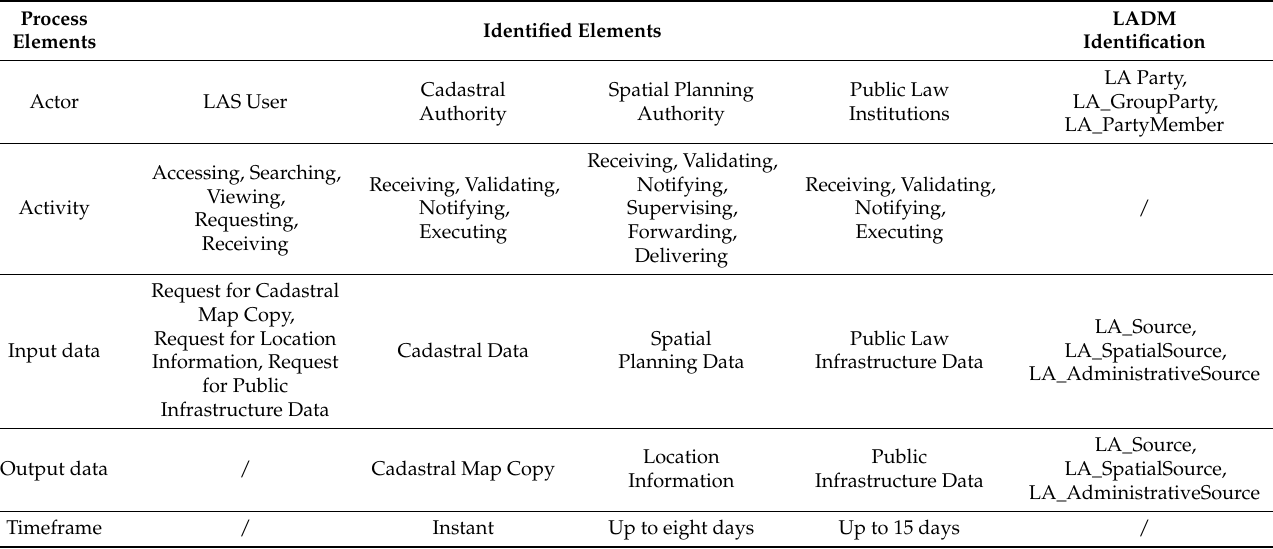
Table 2. Identified elements and connections to